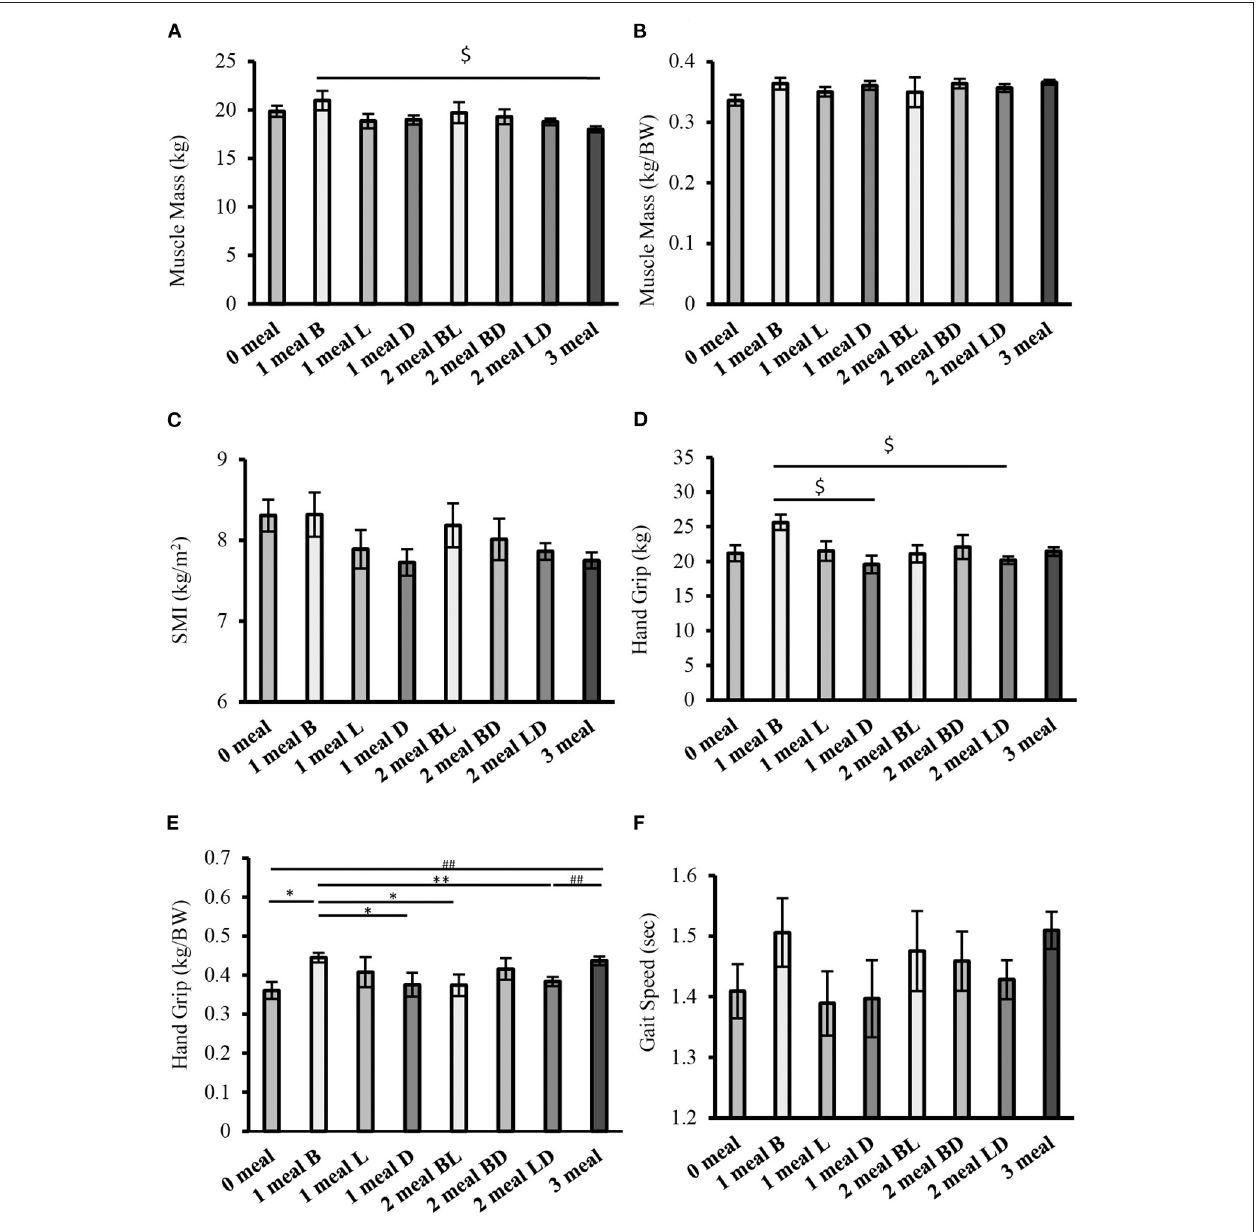
FIGURE 4 | Comparison of sarcopenia-related factors by protein intake pattern (cross-sectional study 2-2). (A) Muscle mass, (B) Muscle mass (weight-corrected), (C) SMI, (D) Handgrip strength, (E) Handgrip strength (weight-corrected), (F) Gait speed. Values are expressed as mean and standard error. $ P < 0.05 compared to 1 meal B (one-way ANOVA), * P < 0.05, ** P < 0.01 compared to 1 meal B (Mann-Whitney), ## P < 0.01, compared to 3 meals (Mann-Whitney), BW, Body Weight; SMI, Skeletal Muscle Index; B, Breakfast, L, Lunch; D, Dinner; BL, Breakfast and Lunch; BD, Breakfast and Dinner; LD, Lunch and